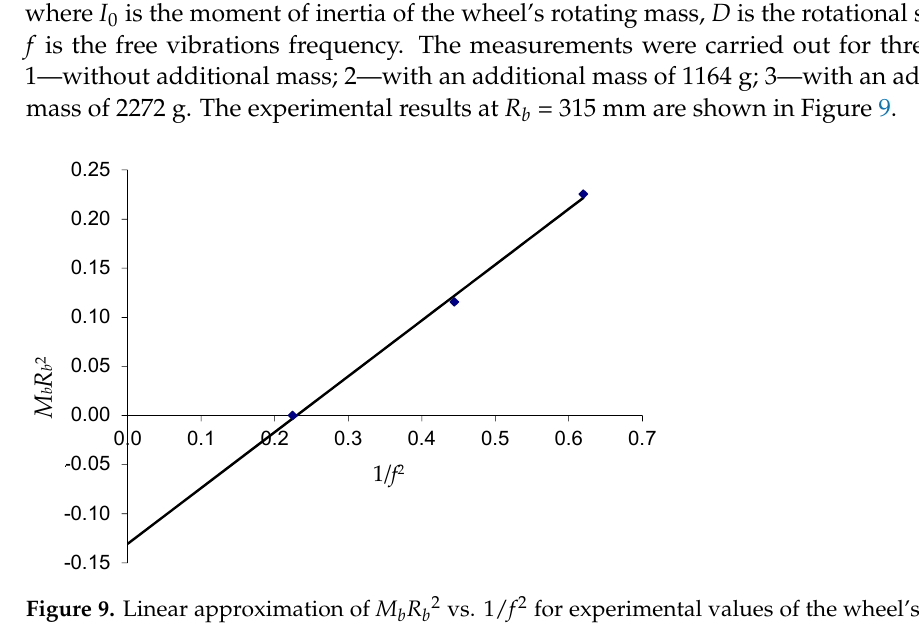
12 of 18 Figure 8. Experimental setup for measuring the moment of inertia of rotating masses: 1–elastic rod, 2–additional masses, 3–flexible belt. From the expression of the frequency of a system